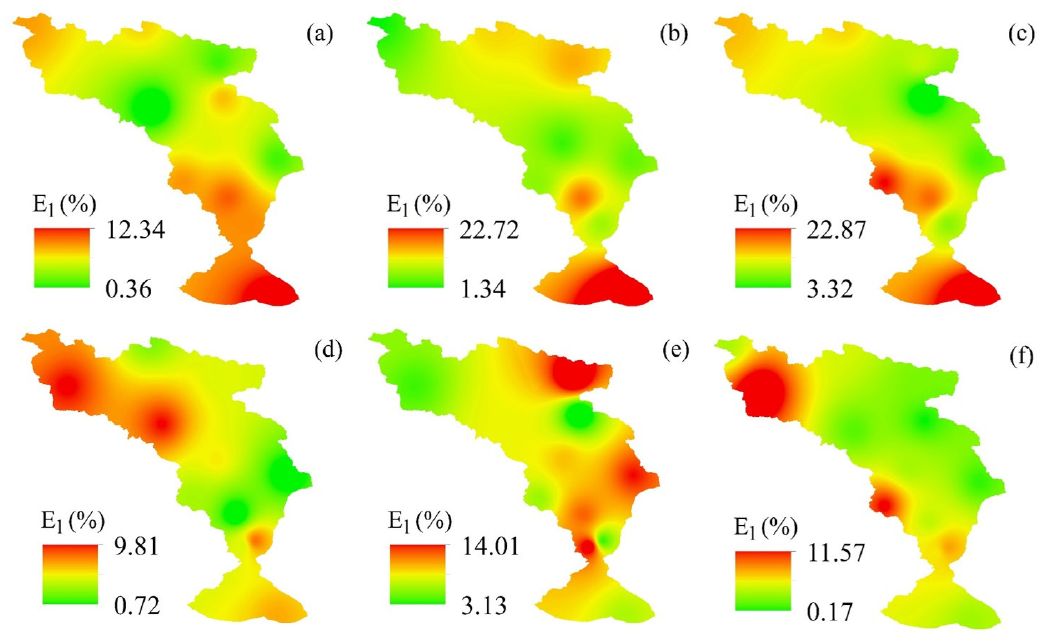
Figure 10. Spatial variation of soil fractionation ratio ( E 1 ) in summer 2018 ( a – c ) and 2019 ( d – f ).